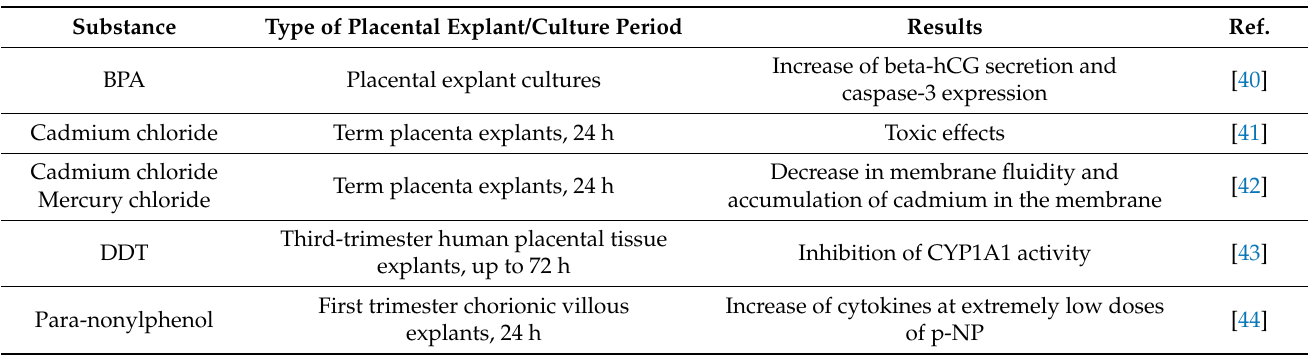
Table 2. Examples of toxicological assays and outcomes on placental tissue